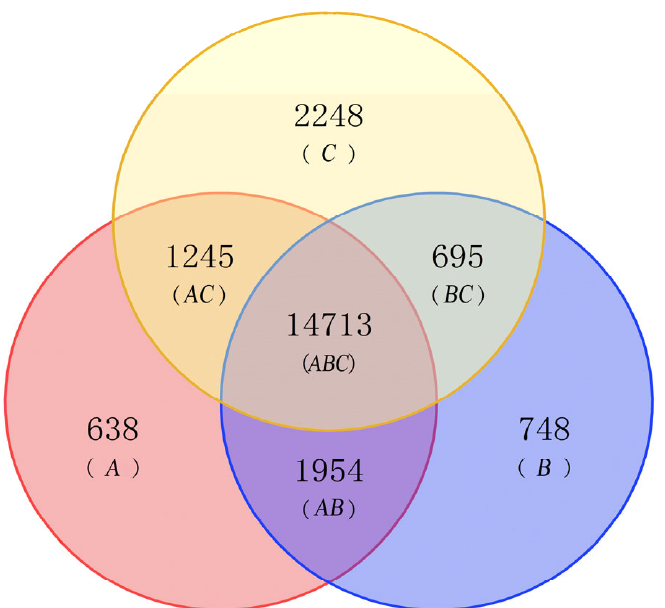
Figure 1. Venn diagrams for flowers metabolites. A. red for CLW; B. blue for CLT; C. yellow for TH. AB. common substances to CLW and CLT; AC. common substances to CLW and TH; BC. common substances to CLT and TH; ABC. common to CLW, CLT, TH groups. Note: CL, O. longilobus ; CLW, O. longilobus wild flowers; CLT, O. longilobus transplant flowers; TH, O. taihangensis wild fl owers.